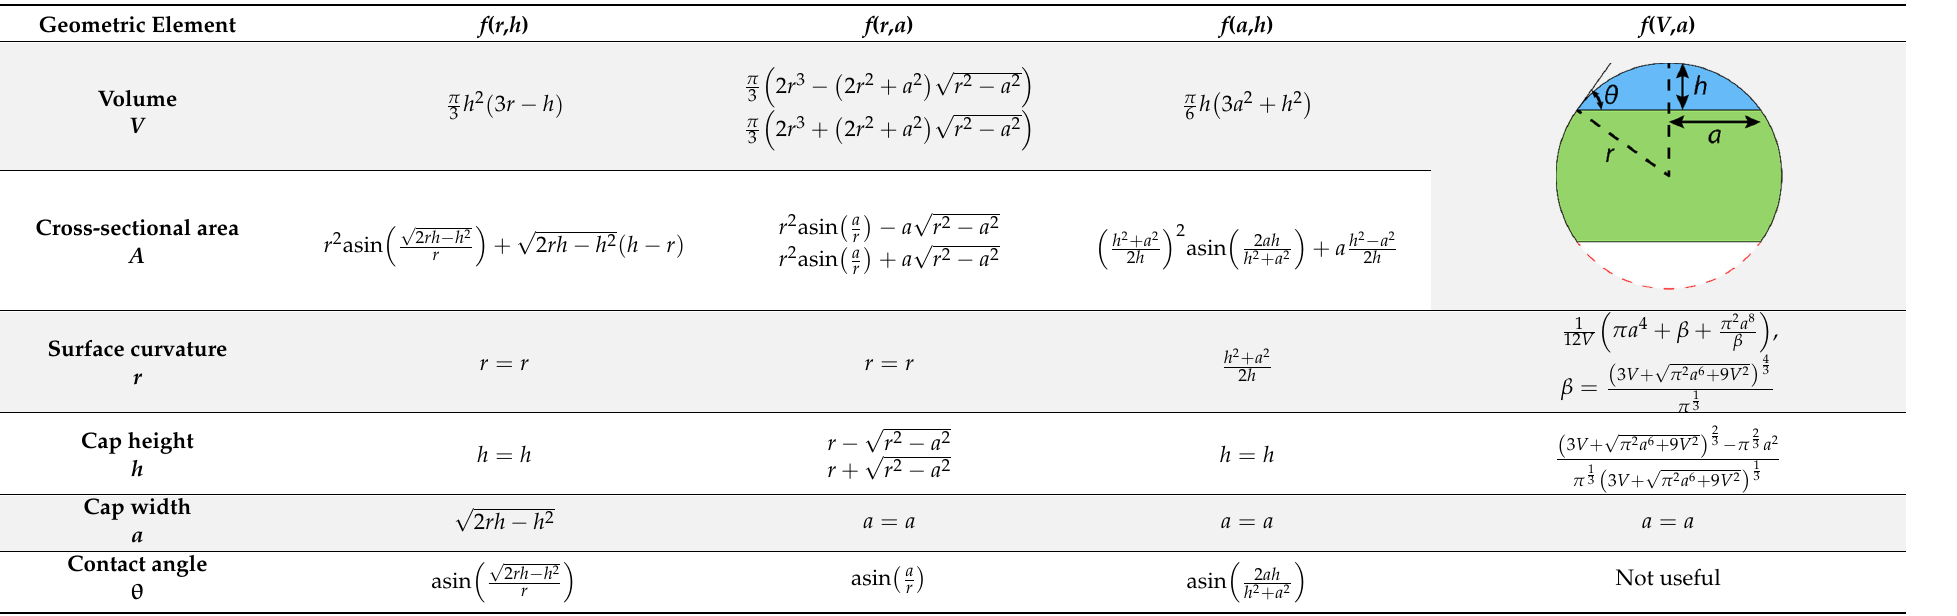
Table 2. Useful relationships between the various geometric elements of a spherical cap are included herein. Equations for subhemispherical caps are written in blue and equations for suprahemispherical caps are written in green.